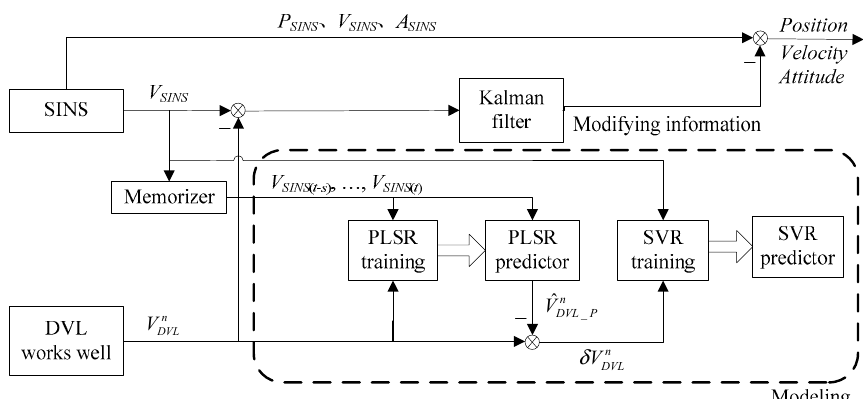
Figure 4. The block diagram of modeling mode.